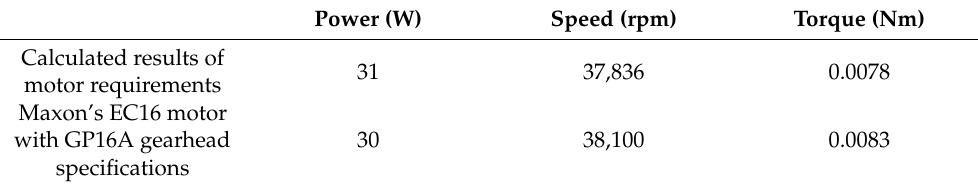
Calculated results